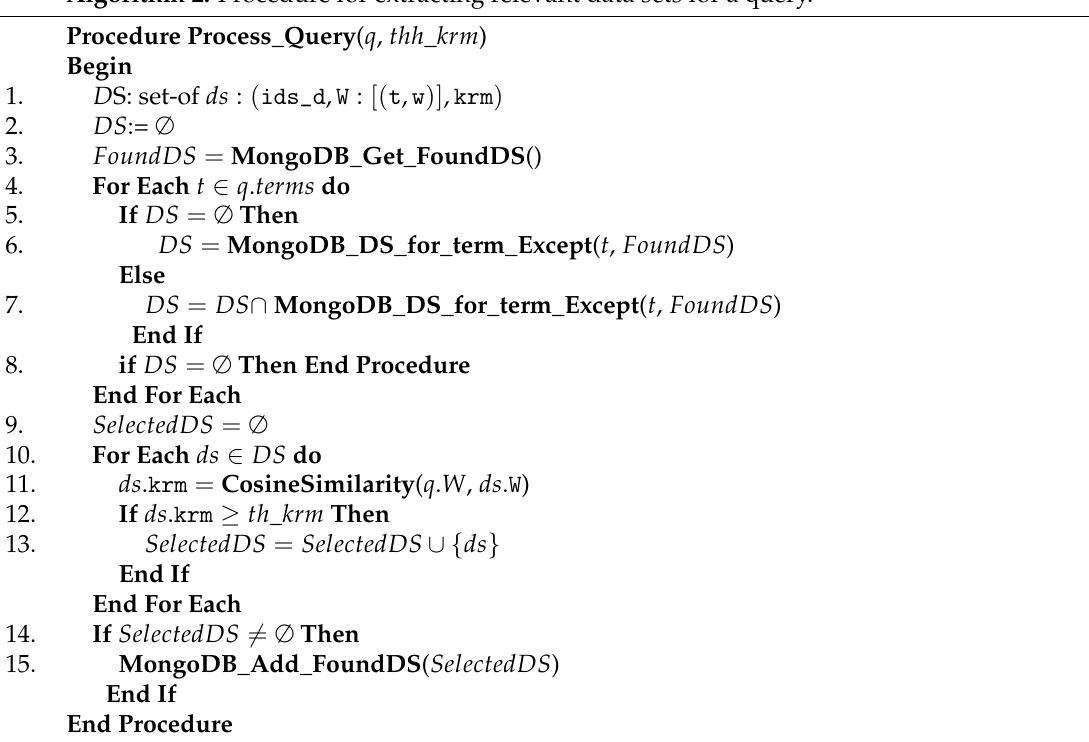
Algorithm 2: Procedure for extracting relevant data sets for a